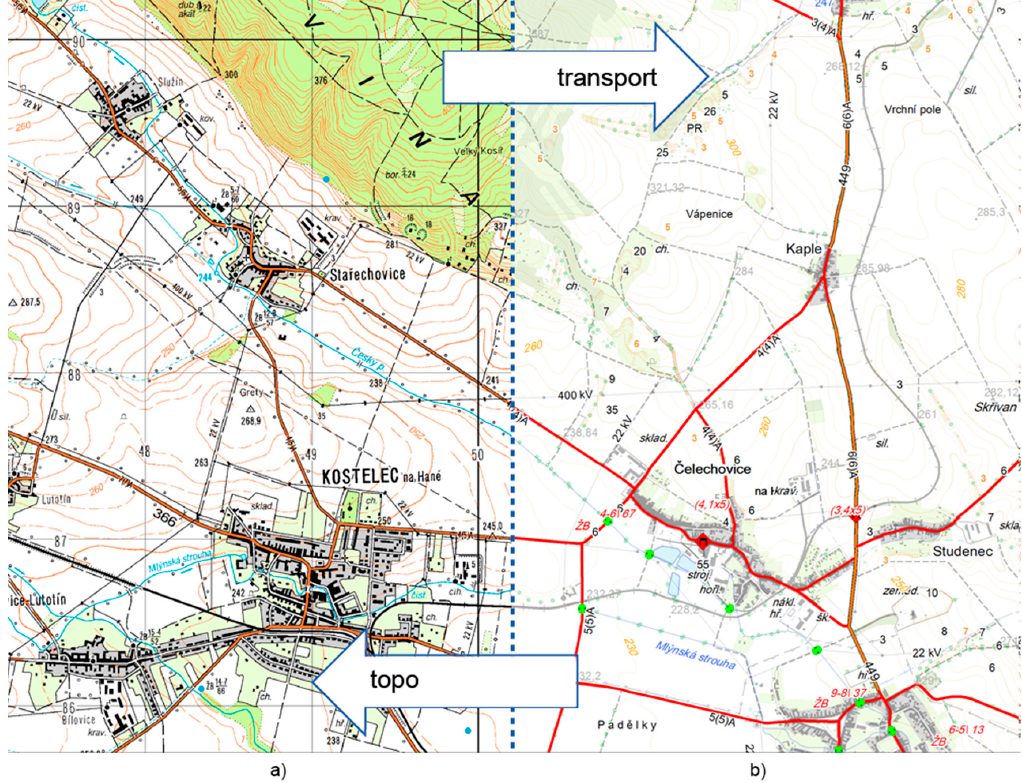
Figure 12. Topographic map ( a ) and contextual transport map ( b ).